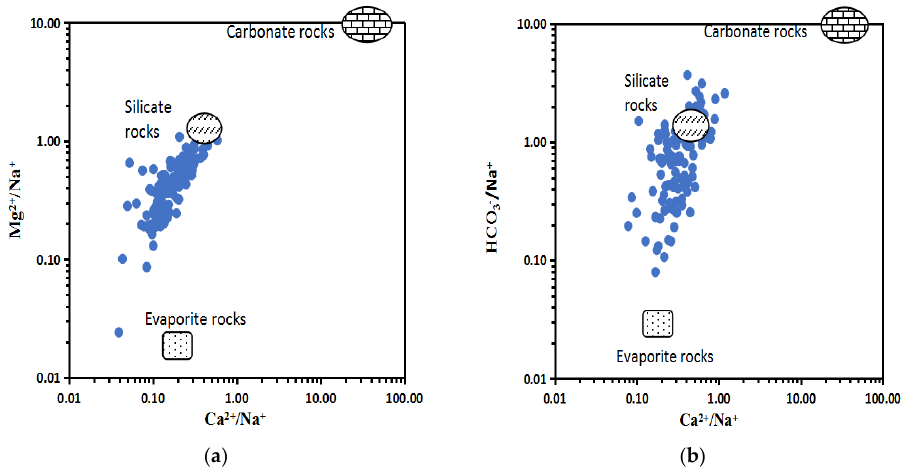
Figure 5. End-member diagrams for groundwater samples collected from the Jinta Basin, China. ( a ): Mg 2+ / Na + versus Ca 2+ /Na + , ( b ): HCO 3 − / Na + versus Ca 2+ /Na + .